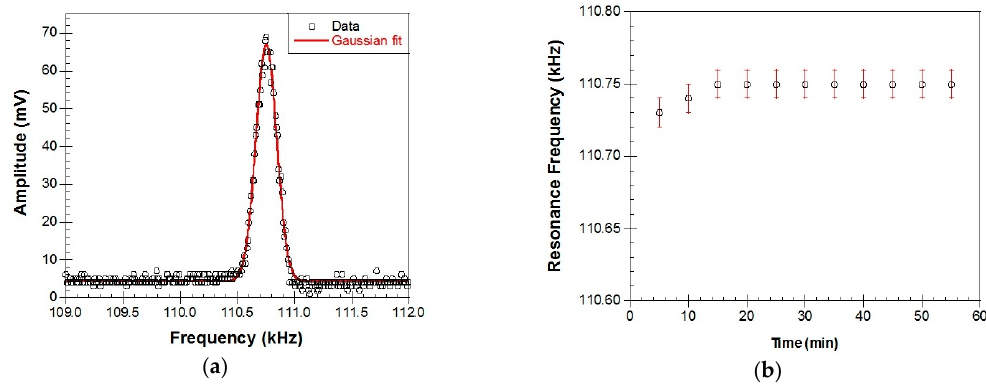
Figure 11. Magnetoelastic resonance measurements: ( a ) a typical resonance signal received when the Metglas/ZnO/Hb electrode is immersed in the PBS solution. The continuous line is a Gaussian fit to the data; and ( b ) resonance frequency versus time when the electrode is immersed in PBS solution.